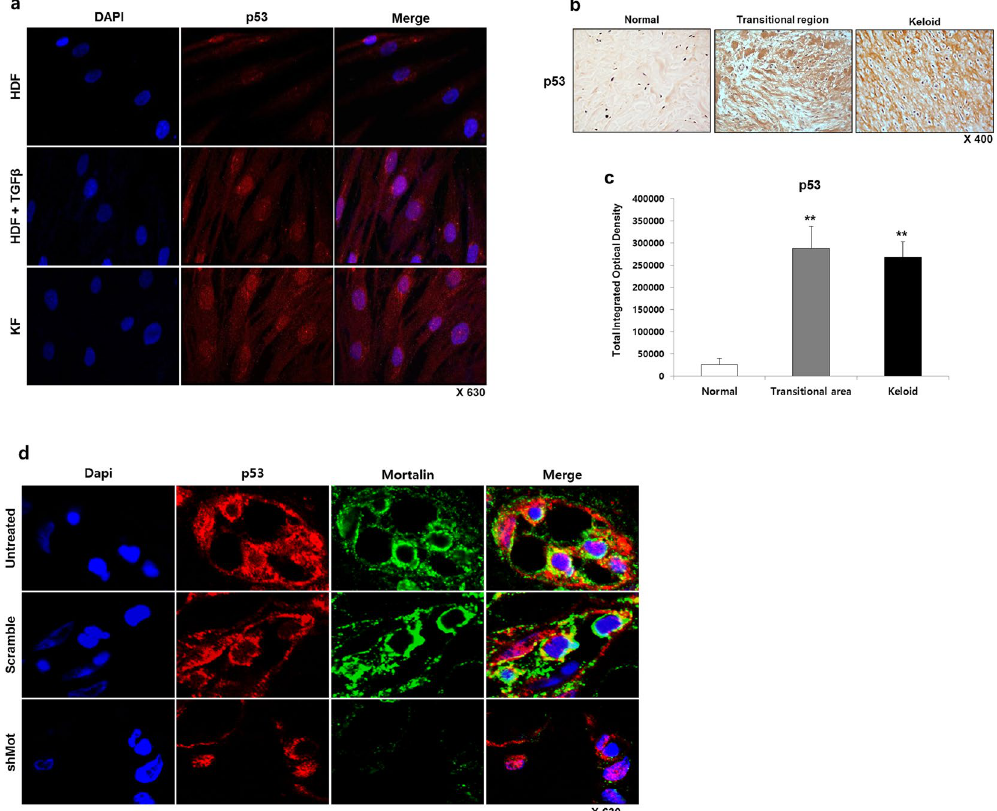
Figure 6. Mortalin interacts with p53 and its knockdown relocates p53 to the cell nucleus in primary keloid spheroids. ( a ) p53 immunofluorescence staining of HDFs, TGF- β 1-activated HDFs, and KFs. A clear and strong localization of p53 is shown from the cytoplasm and nucleus of TGF- β 1-activated HDFs and KFs, compared to its HDFs (p53, red; nucleus, blue; x680). ( b – c ) Expression of p53 protein markedly increased in central and transitional keloid region compared to adjacent normal tissue by approximately 10 times (n = 6) ( ** p < 0.01). ( d ) Mortalin silencing-induced apoptosis is mediated by nuclear translocation of mutant p53. Colocalizations of p53 and mortalin in the cytosol were investigated on the untreated keloid spheroid. Double immunostaining images of mortalin specific shRNA-expressing adenovirus treated keloid spheroids show mortalin knockdown- induced nuclear translocation of p53 (mortalin, green; p53, red; DAPI,